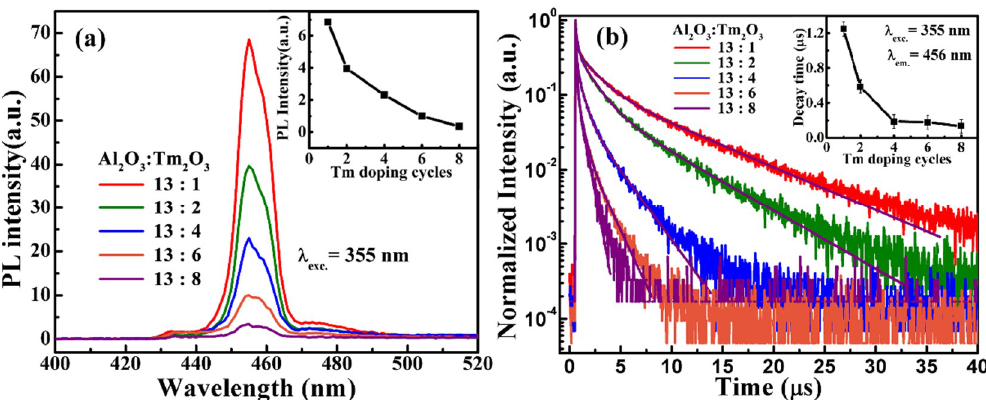
Figure 1. The ( a ) photoluminescence (PL) and ( b ) time-resolved photoluminescence (TRPL) spectra from the nanolaminate Al 2 O 3 /Tm 2 O 3 films with different Tm dopant cycles excited by a 355 nm laser. The insets present the tendency of these PL intensities and PL decay lifetime with the Tm dopant cycles.